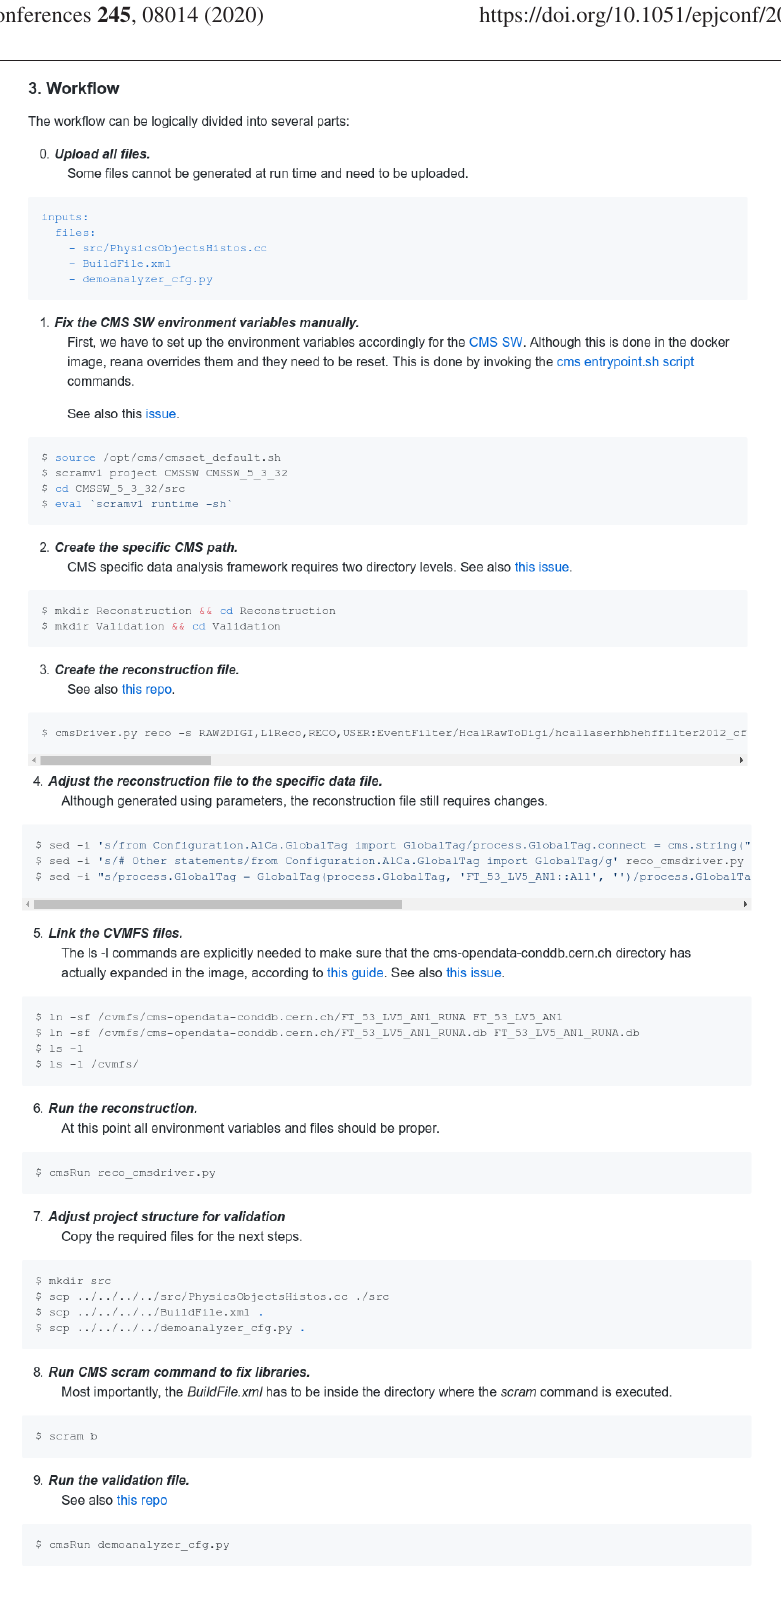
Figure 6. An individual reconstruction workflow and its runtime